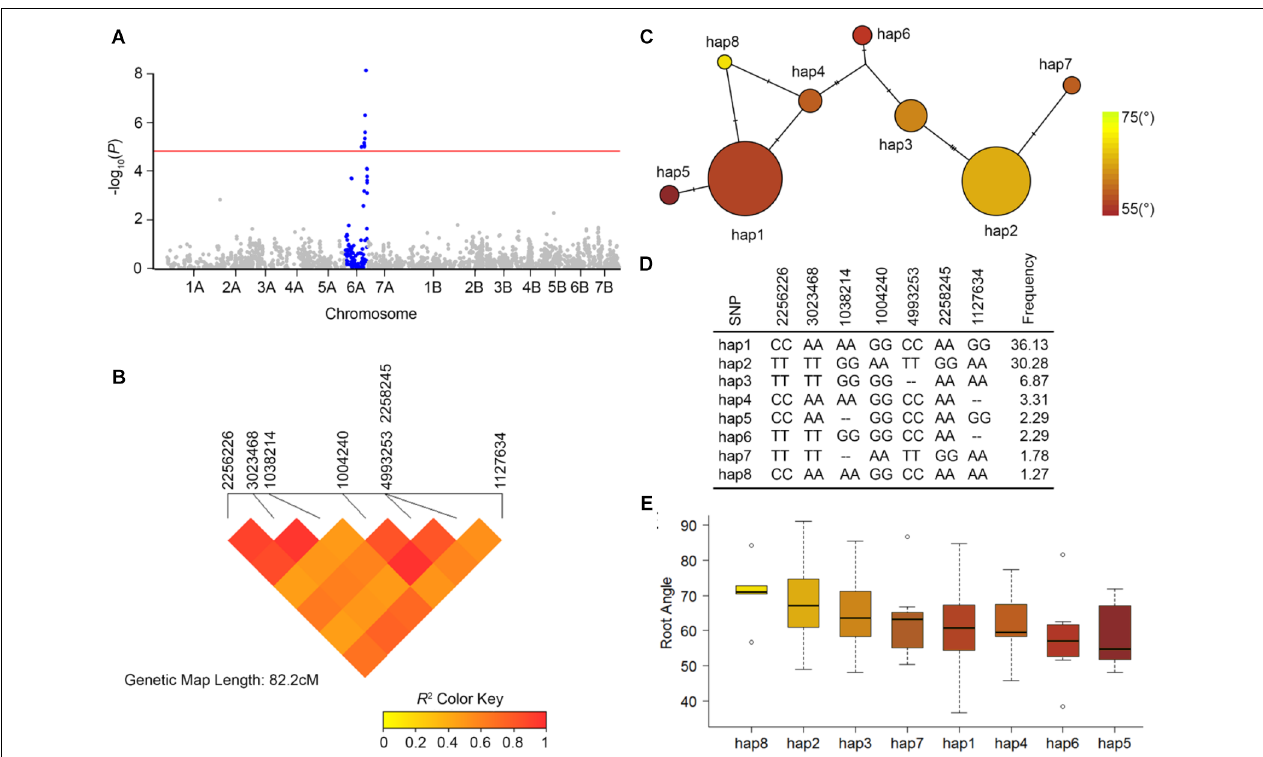
FIGURE 4 | Genome-wide association mapping for seminal root angle in 393 durum lines using 2,541 high quality DArTseq markers (minor allele frequency > 5%). (A) Manhattan plot showing chromosome 6A (blue) with significant marker-trait association at Bonferroni significant threshold 4.67 (red horizontal line). The x -axis displays the DArTseq markers on 14 chromosomes; y-axis is the –log 10 ( P ). (B) Heat map showing pairwise linkage disequilibrium (LD) between 7 significant markers representing major seminal root angle QTL on chromosome 6A ( qSRA-6A ). Color gradient represents LD as r 2 . (C) Haplotype network of 8 haplotype variants of the qSRA-6A that were found in the 393 NAM lines. Size of the circles represents the frequency of each haplotype in the population. Node color indicates mean seminal root angle for lines carrying the haplotype. (D) Allelic marker-combination of the 8 haplotypes for the 7 DArTseq markers and the frequency value of each haplotype. (E) Seminal root angle variation in each